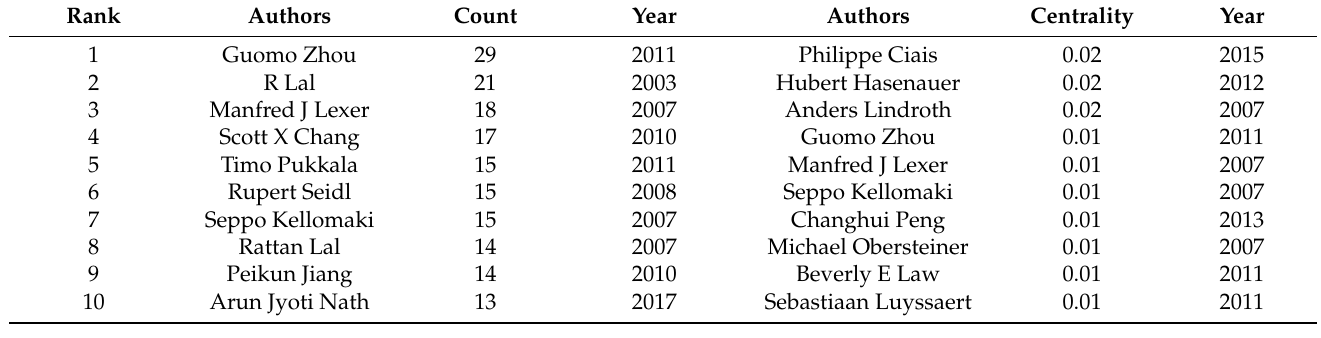
Table 4. Top 10 authors with the highest number of publications and centrality.